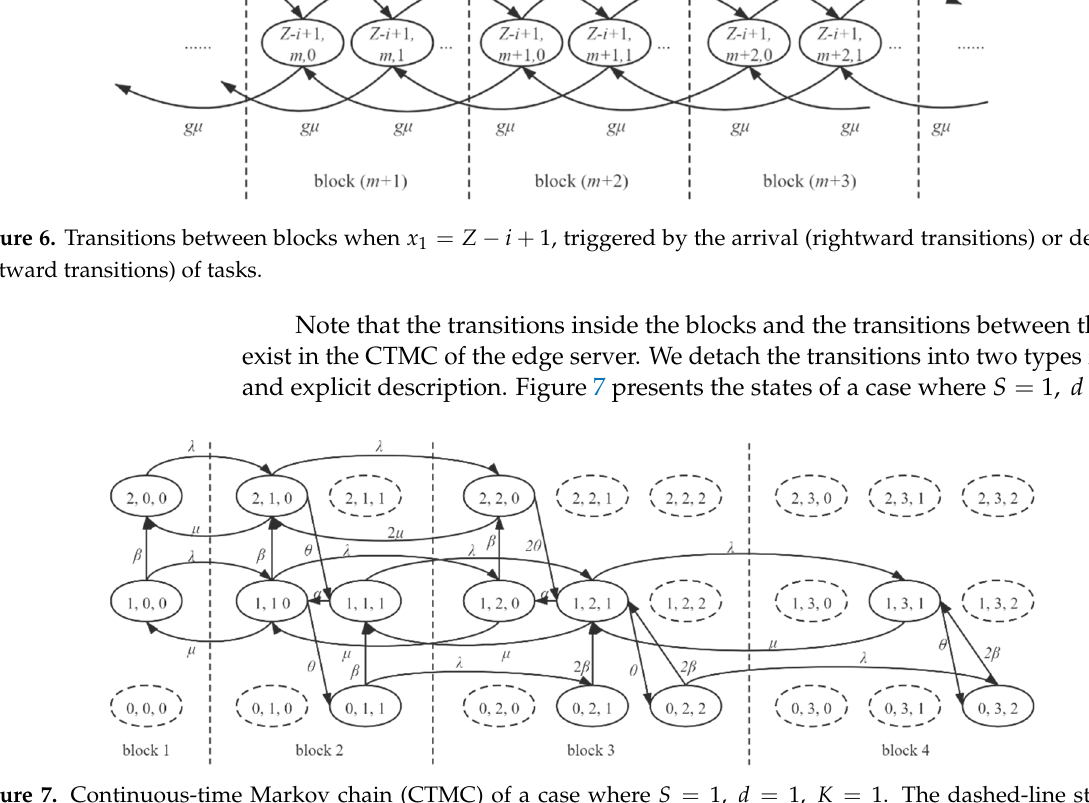
Figure 5. Transitions inside the blocks, triggered by failure (transitions toward bottom-right), mi- gration (leftward transitions), and reboot (upward transitions) of VM. 𝑛 = min(𝑥 (cid:2870) , 𝑍) .